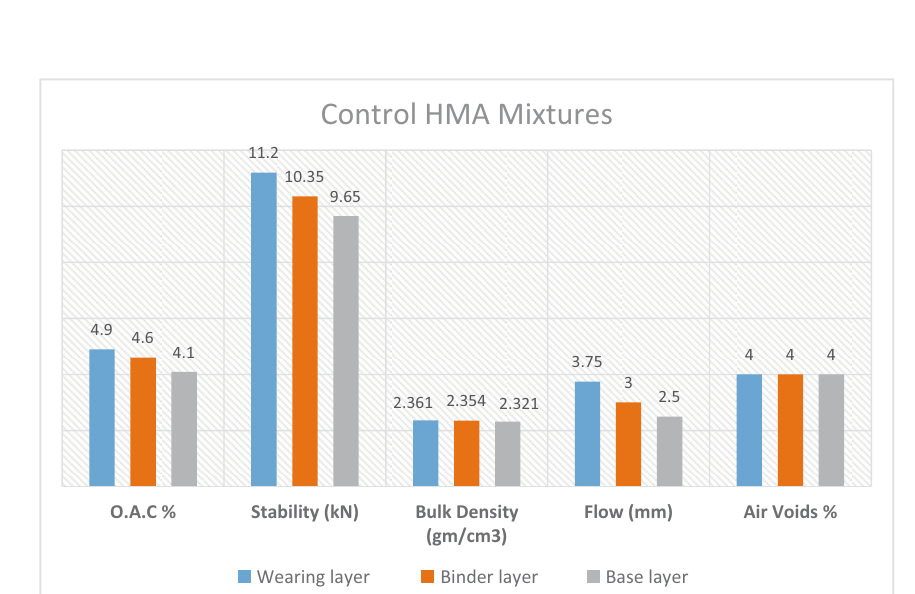
Figure 9: Comparison of Marshall properties between the selected layers.